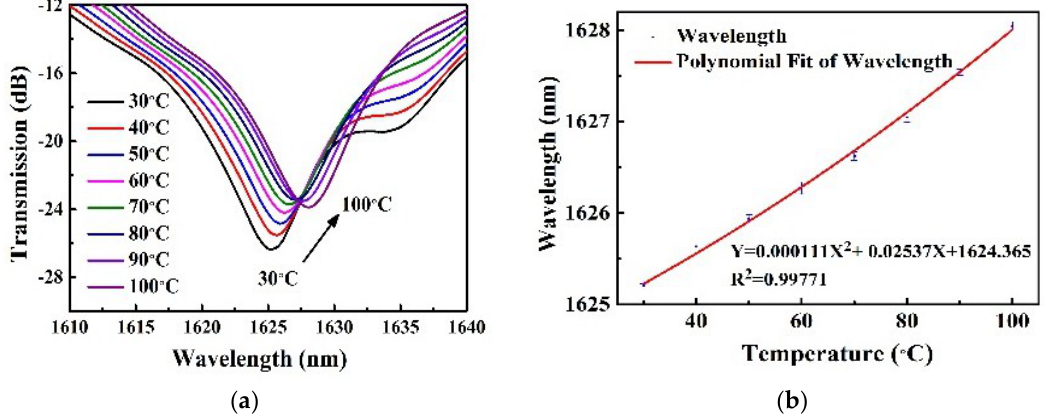
Figure 6. ( a ) Transmission spectra evolution of the 4FM-LPFG with the temperature increased from 30 °C to 100 °C in steps of 10 °C; ( b ) Relationship between the resonant wavelength and the temperature.